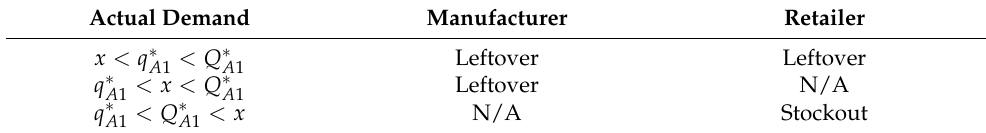
(cid:0) (cid:1) r , w , q ∗ , Q ∗ . A 1 A 1